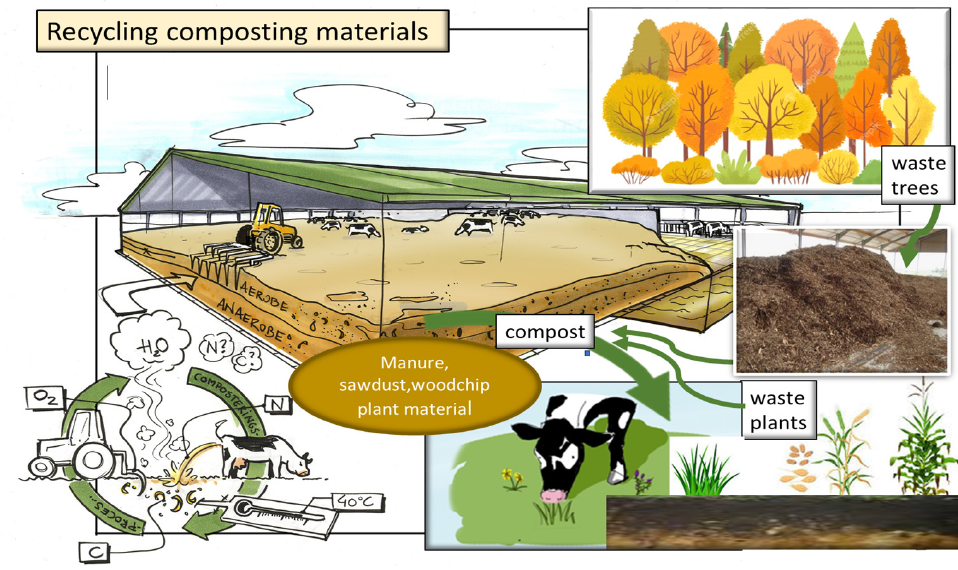
Figure 4. Dairy farm with compost bedded-pack and its application in the field. Source: Authors.